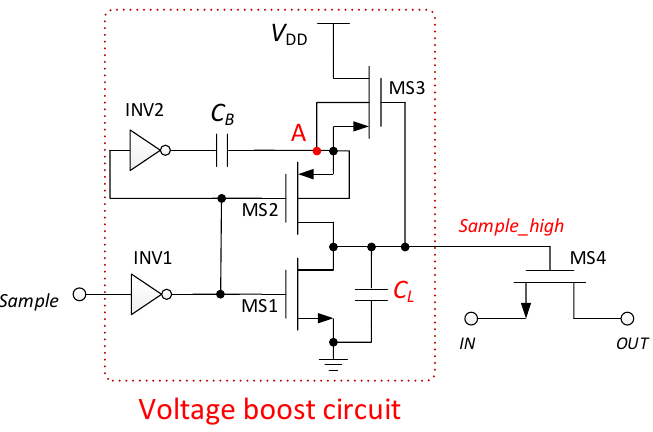
Figure 8. Voltage bootstrap sampling circuit.